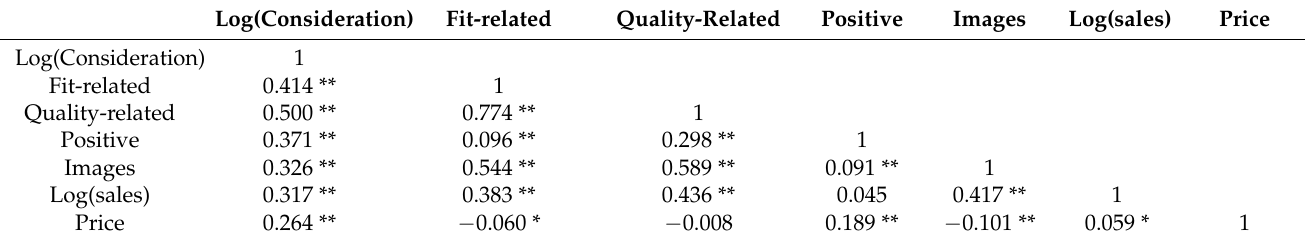
Table 3. Correlation matrix of variables.